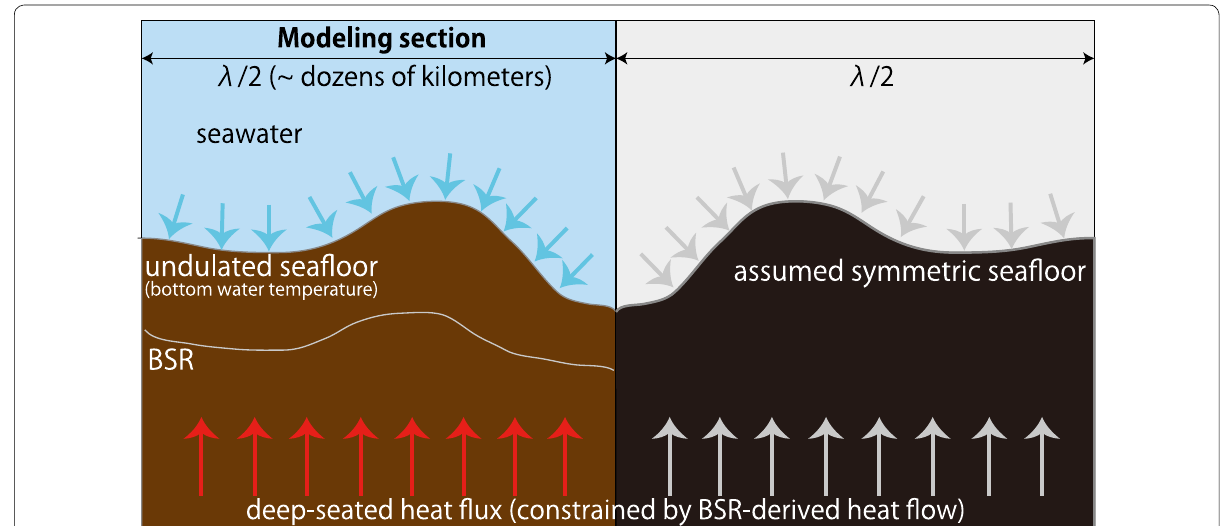
Fig. 5 Schematic illustration of the thermal model. Note that this model modified Blackwell et al.’s (1980) protocol by adopting the temperature at BSR depths as the